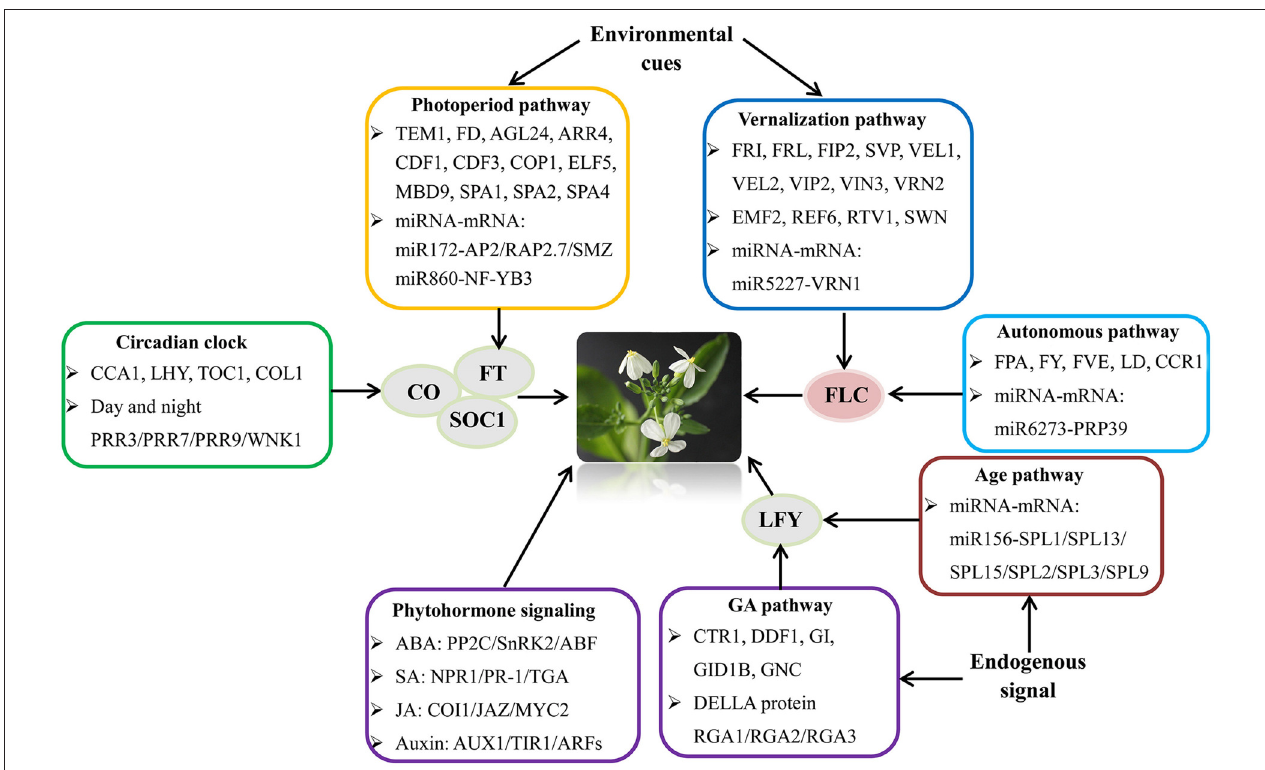
FIGURE 5 | The putative model of flowering regulatory network integrating various flowering pathways and transcriptional processes in radish. The FT , SOC1 , LFY , FLC, and CO genes were flowering pathway